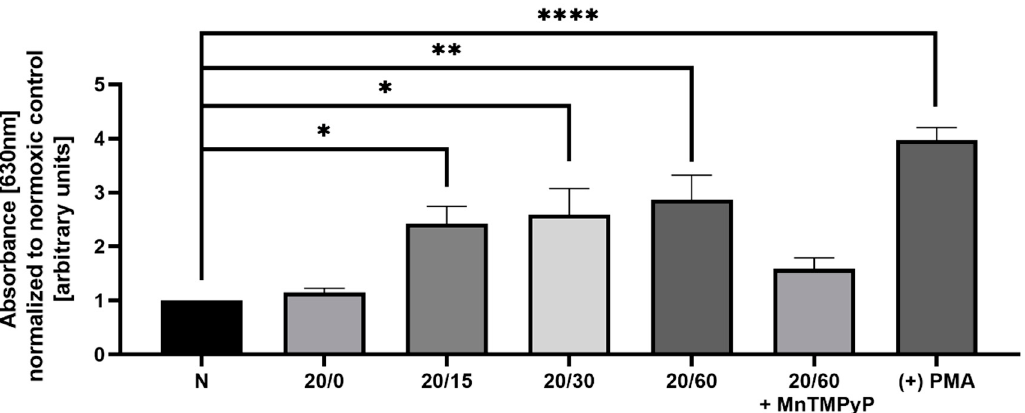
Figure 3. Pretreatment of OGD/R-exposed U251-MG cells with MnTMPyP antagonized reactive oxygen species (ROS) generation. Spectrophotometric quantification of ROS following either OGD/R or normoxic conditions with or without pre-treatment of MnTMPyP (100 µM) utilizing nitroblue tetrazolium chloride (NBT), to examine ROS production (n = 3). Phorbol 12-myristate 13-acetate (PMA; 1 µM for 15 min) was used as a positive control. * p < 0.05; ** p < 0.01; **** p < 0.0001; ANOVA with Tukey’s post hoc test comparing OGD/R conditions to normoxic control ± MnTMPyP). Data are expressed as mean ± SEM.